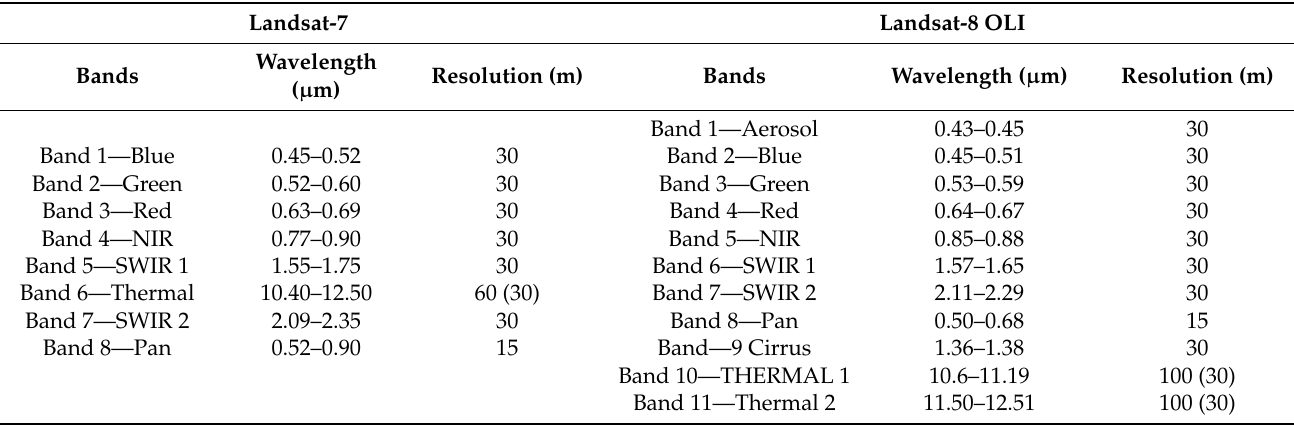
Table 1. Characteristics of Landsat-7 ETM+ and Landsat-8 OLI and TIRS.